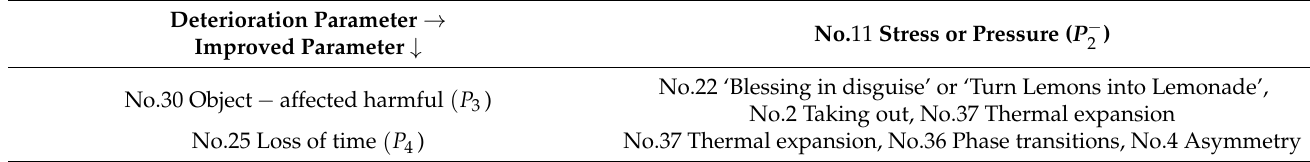
Table 12. Invention principles corresponding to conflicts of “TCM accumulation at outlet”.